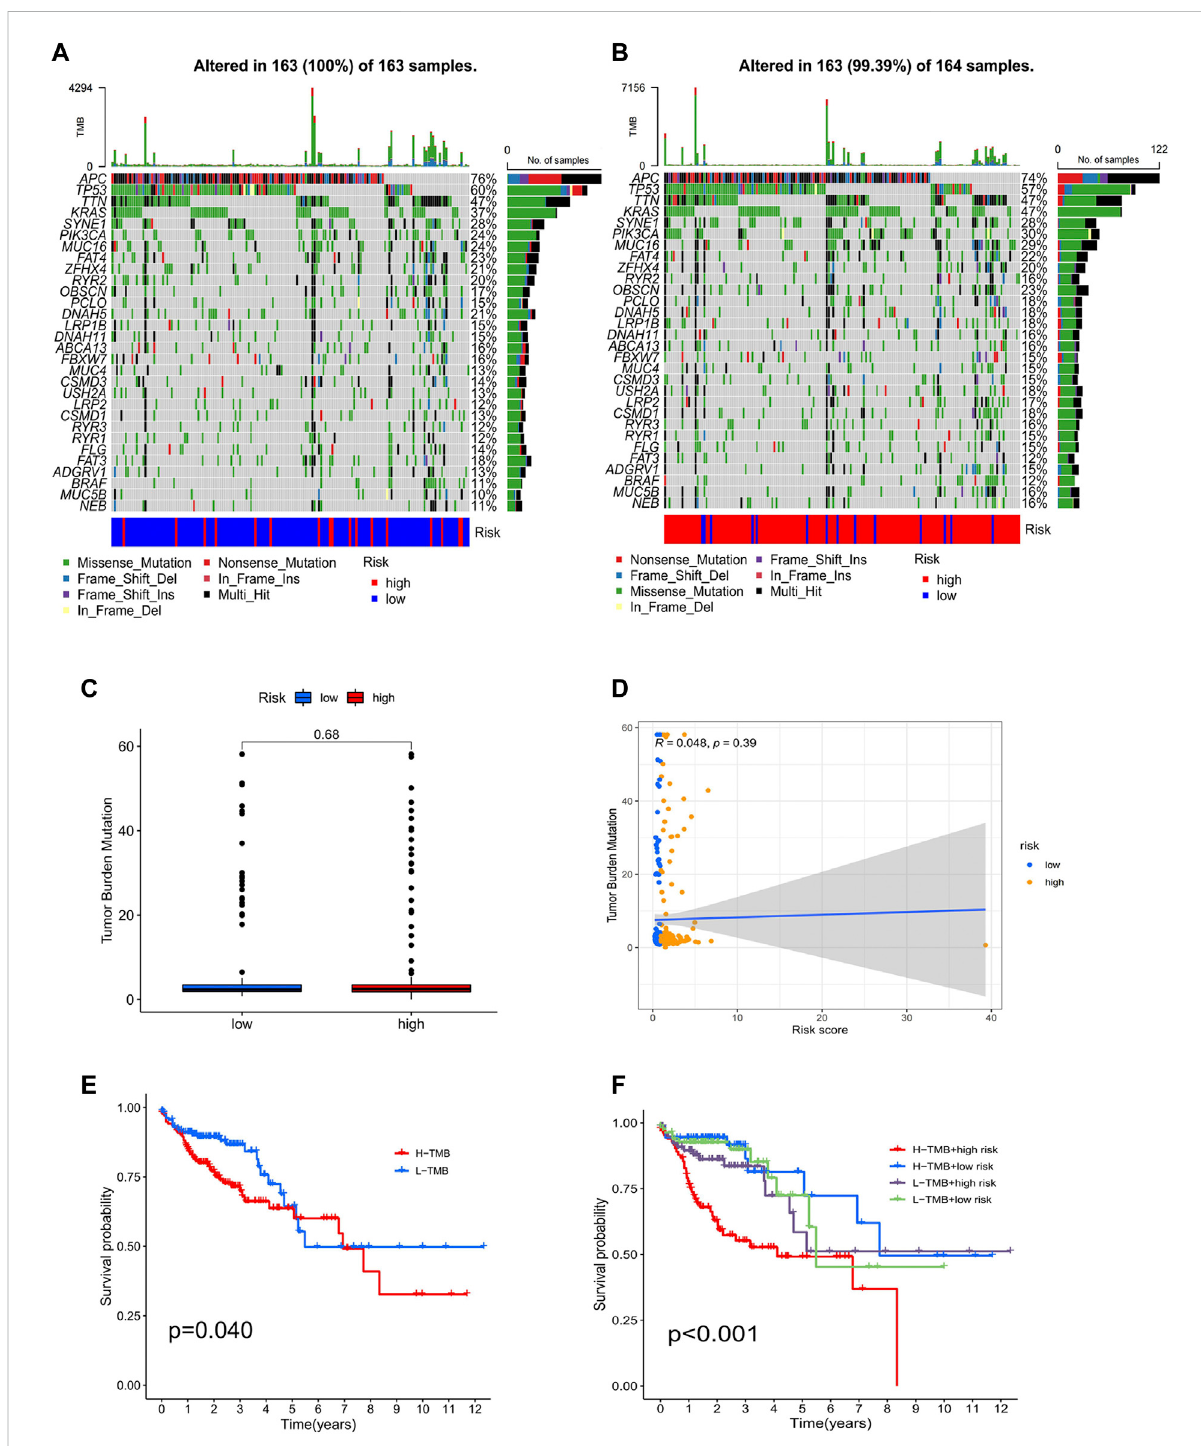
FIGURE 11 Analysis of tumor mutational burden. Mutations in the top 30 genes with the highest mutation frequency in low- (A) and high-risk groups (B) . Boxplots (C) and scatterplots (D) of the correlation between risk score and TMB. (E) K – M analysis of TMB. (F) K – M analysis of TMB combined with a risk